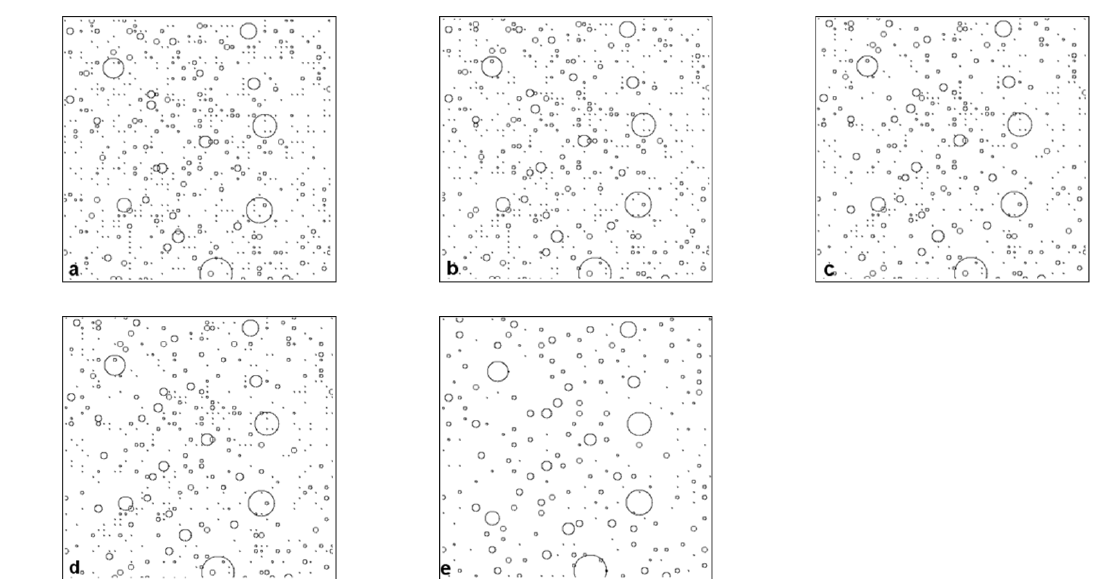
Figure 8. Procedure of mineral size transformation as φ = 0.1: ( a ) Conversion = 20.0%; ( b ) Conversion = 40.0%; ( c ) Conversion = 60.0%; ( d ) Conversion = 80.0%; ( e ) Conversion = 100%.